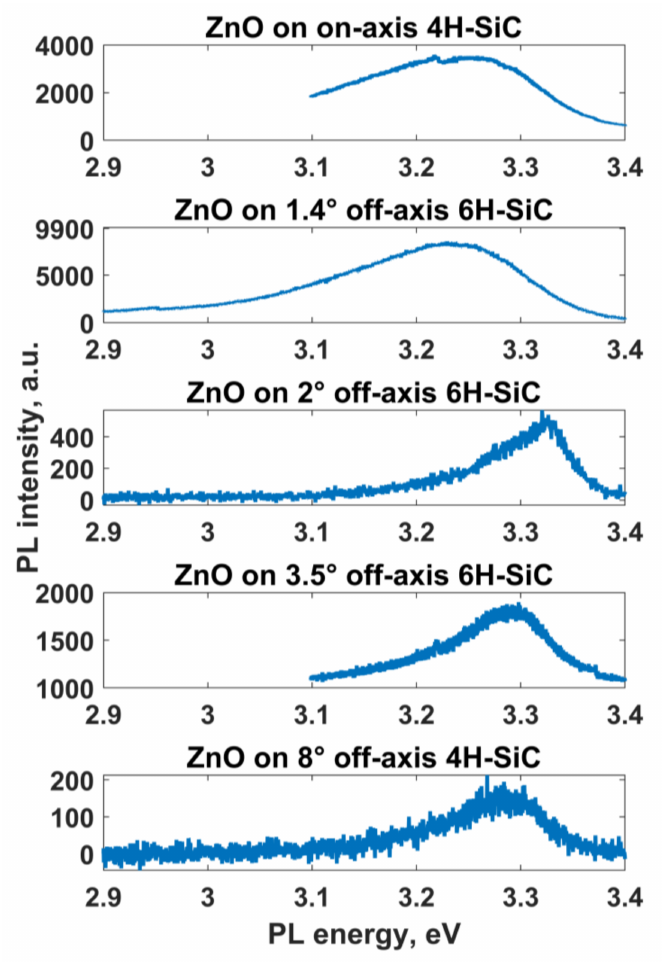
Figure 5. Room temperature PL spectra collected from ZnO films grown on SiC substrates with different off-cut angles: off-axis angle increases from the top panel to the bottom